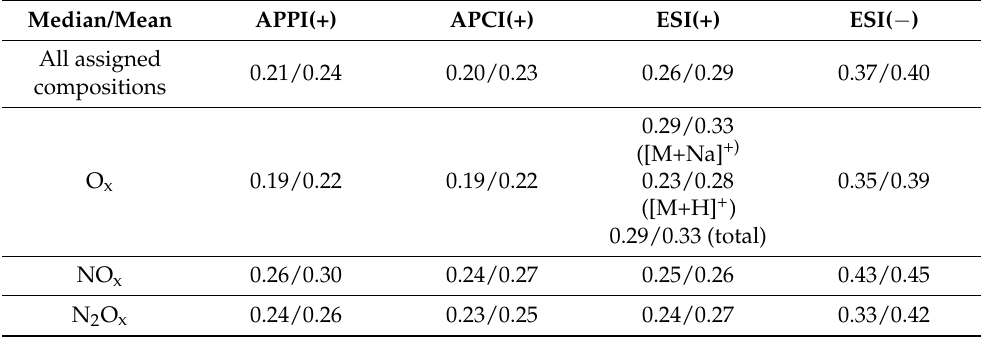
Table 1. Calculated median and mean O/C values for detected